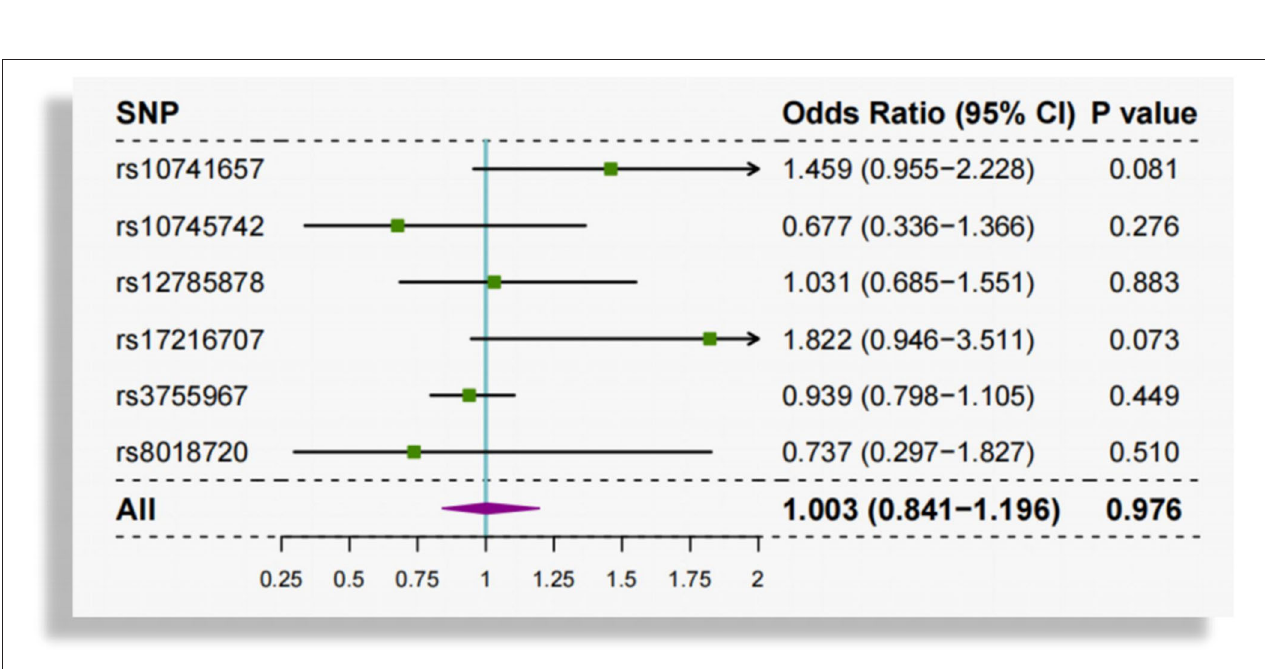
FIGURE 3 | Single SNP analysis of genetically predicted circulating vitamin D and atrial fibrillation. SNP, single-nucleotide